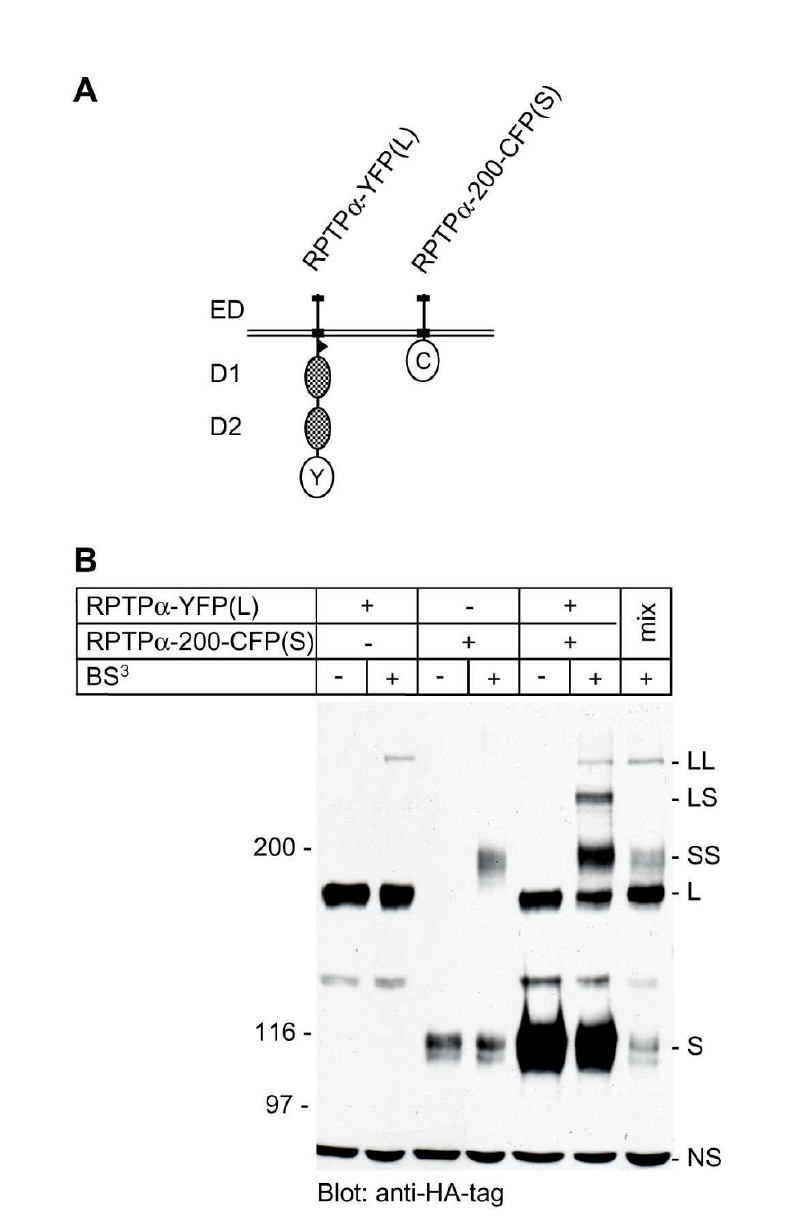
Figure 4 Homodimerization of RPTP α as assessed using a chemical cross-linker. ( A ) Distinct RPTP α constructs with different molecular weights were used to be able to discriminate between them. The long form (L) is a full length RPTP α construct with YFP fused to the C-terminus, while the short form (S) lacks almost all cytoplasmic sequences and contains CFP fused to residue 200, close to the transmembrane domain. ( B ) SK-N-MC cells were transiently transfected with the constructs depicted in (A). The cells were treated with the non-cell-permeable cross-linker, bis [sulfosuccinimidyl]suberate (BS 3 ), or left untreated, as indi- cated. Aliquots of the total cell lysates were run on a 5% SDS-polyacrylamide gel, the gel was blotted, and the immunoblot was probed with anti-HA-tag antibody. The positions of marker proteins that were co-electrophoresed with the samples are indi- cated on the left (in kDa). The position of monomeric RPTP α -YFP (the long form, L), dimeric RPTP α -YFP (LL), monomeric RPTP α -200-CFP (the short form, S), dimeric RPTP α -200-CFP (SS), and of the RPTP α -YFP/ RPTP α -200-CFP heterodimer (LS) are indicated, as well as a non-specific band (NS). Lysates from BS 3 -treated cells that had been transfected with either RPTP α - YFP or RPTP α -200-CFP were mixed (mix), clearly demonstrating that the heterodimer (LS) only formed in cells that had been co-transfected with RPTP α -YFP and RPTP α